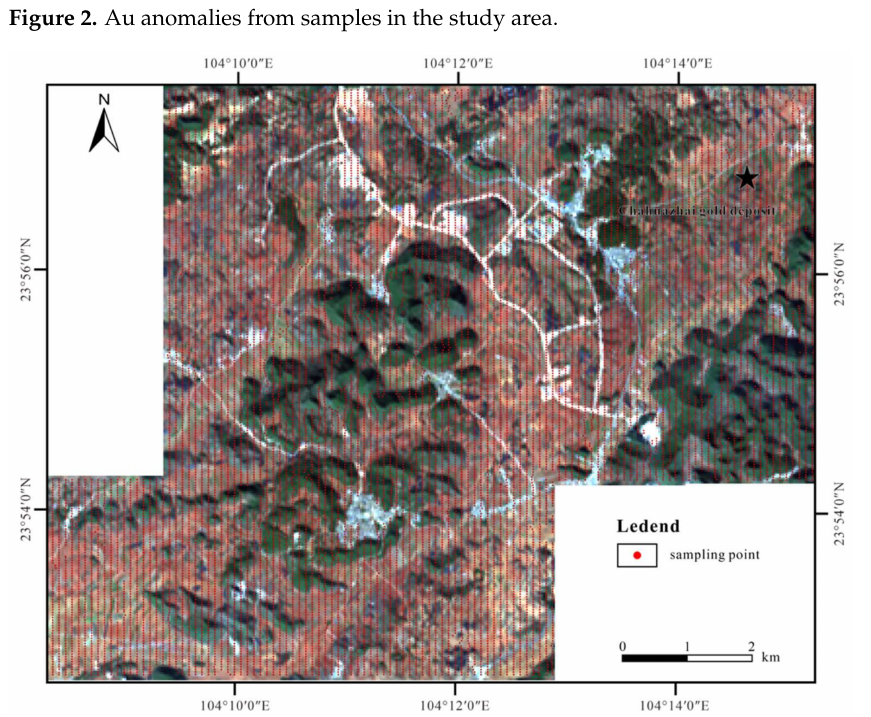
Figure 3. Au geochemical soil samples